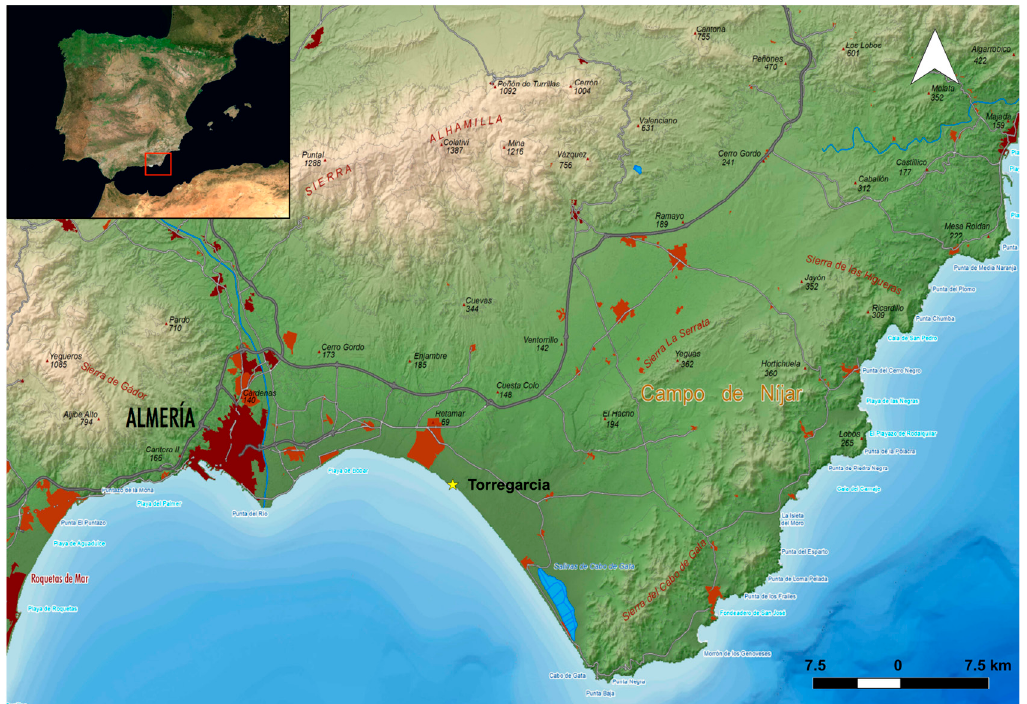
Figure 1. General Map of Almería and Nijar-Cabo de Gata area. Torregarcía Archeological site marked with a star.